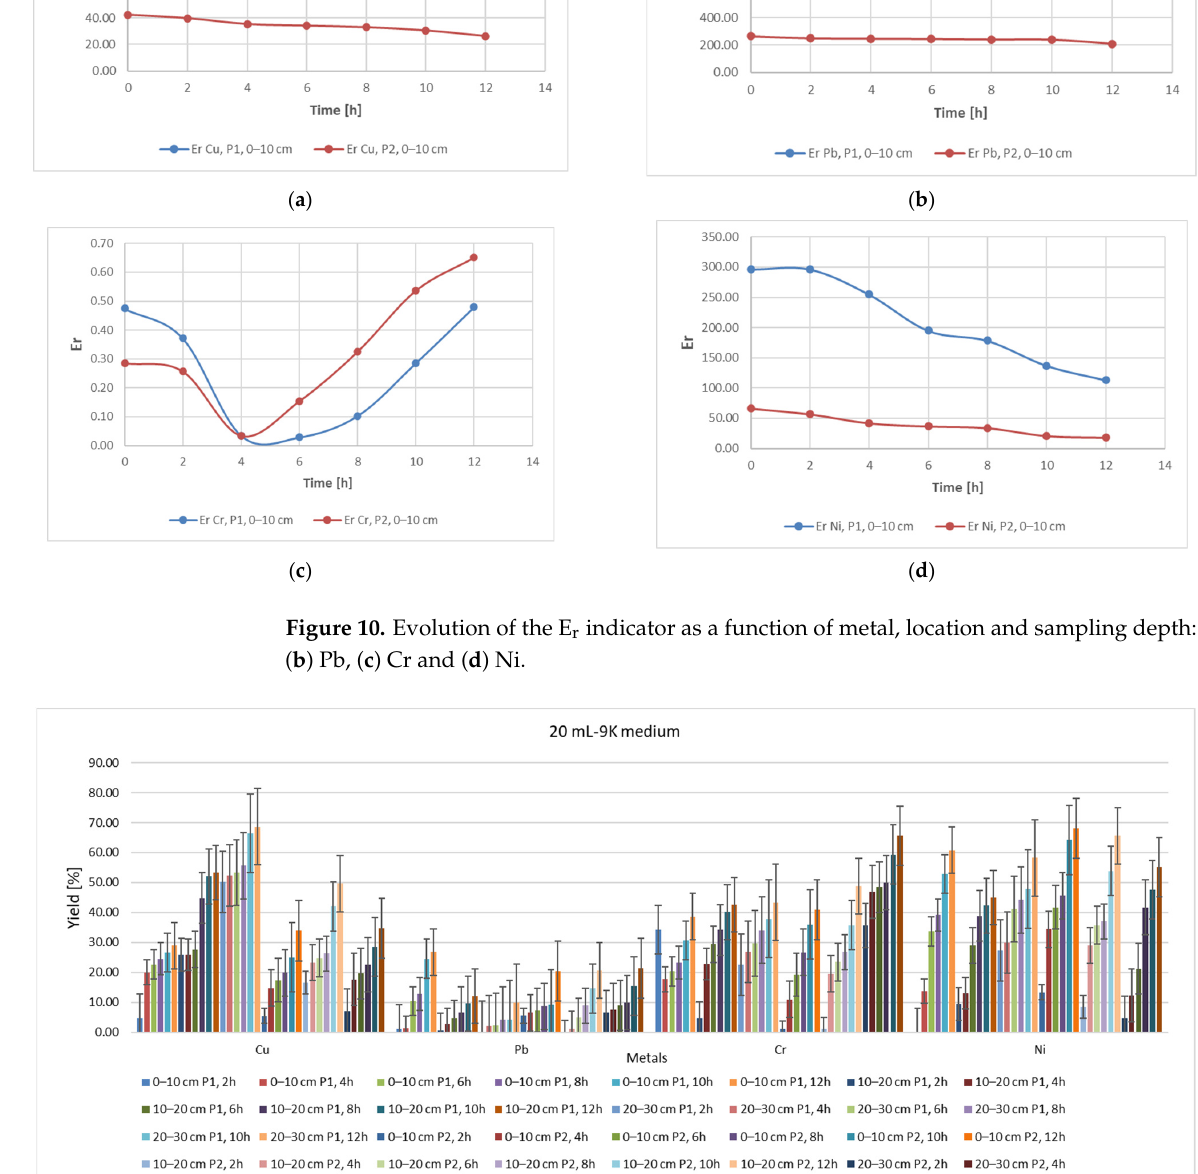
Figure 12. Yield of extraction process with 40 mL of 9K medium. Figure 13. Reduction rate of pollutant concentration, depending on sample, sampling depth, amount of 9K medium and extraction time (20 mL 9K medium).